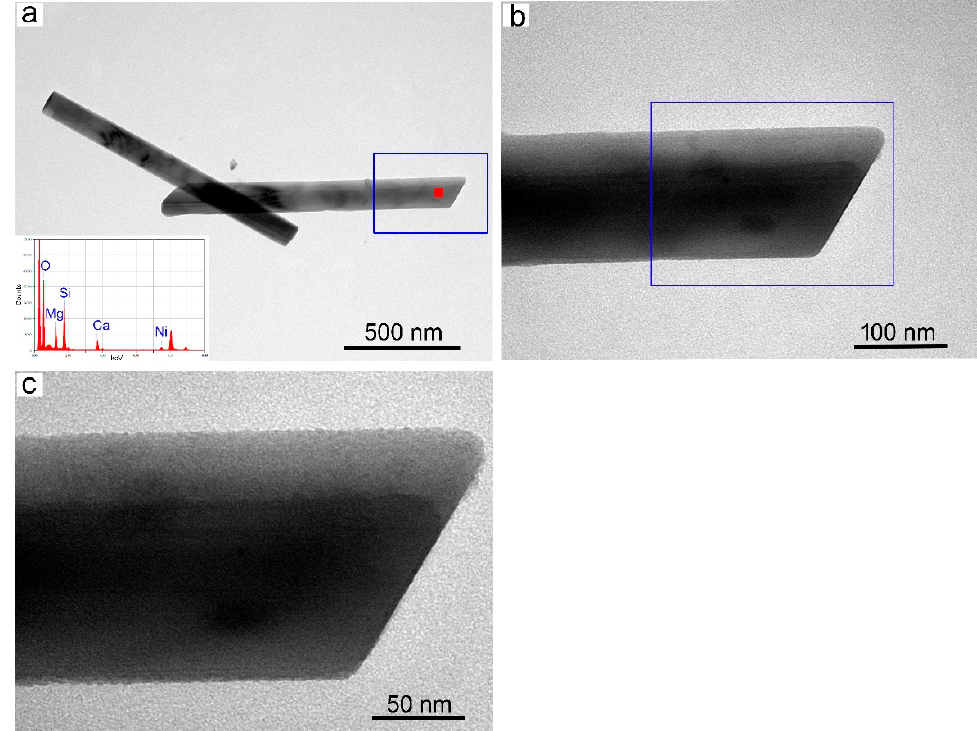
Figure 8. ( a ) TEM micrograph of single Ni-doped tremolite fibers with the relative EDS point analysis (red square); ( b ) zoom of the blue rectangle of Figure ( a ); ( c ) zoom of the blue rectangle of Figure ( b